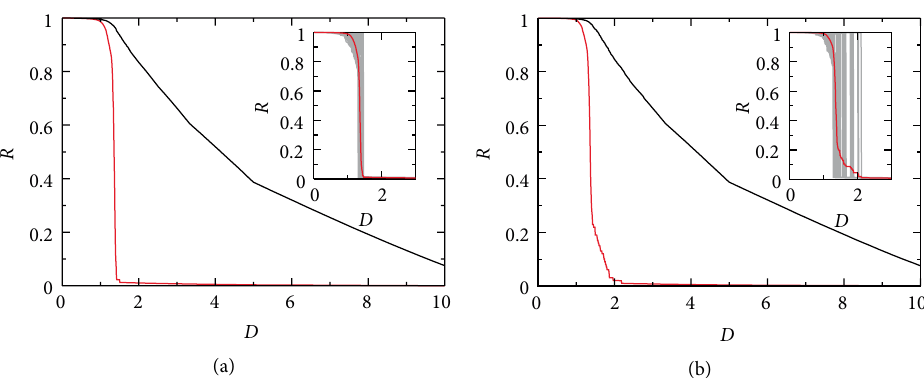
Figure 3: Market robustness 𝑅 as the function of transmitting shock level 𝐷 considering that the initial failure occurs in the VC layer (a) and in the start-up layer (b). The black curve represents the scenario only considering risk contagion via external links while the red line represents the risk propagation with internal and external link coupling effect. In each layer we use 𝑇 = 0.5 and internal structure topology corresponds to a random ER network with ⟨𝑘 in ⟩ = 4 . The weight follows a uniform distribution in [0, 10] . The results were averaged over 100 realizations. In the insets we show 100 individual realizations (gray) and the average curve (red).